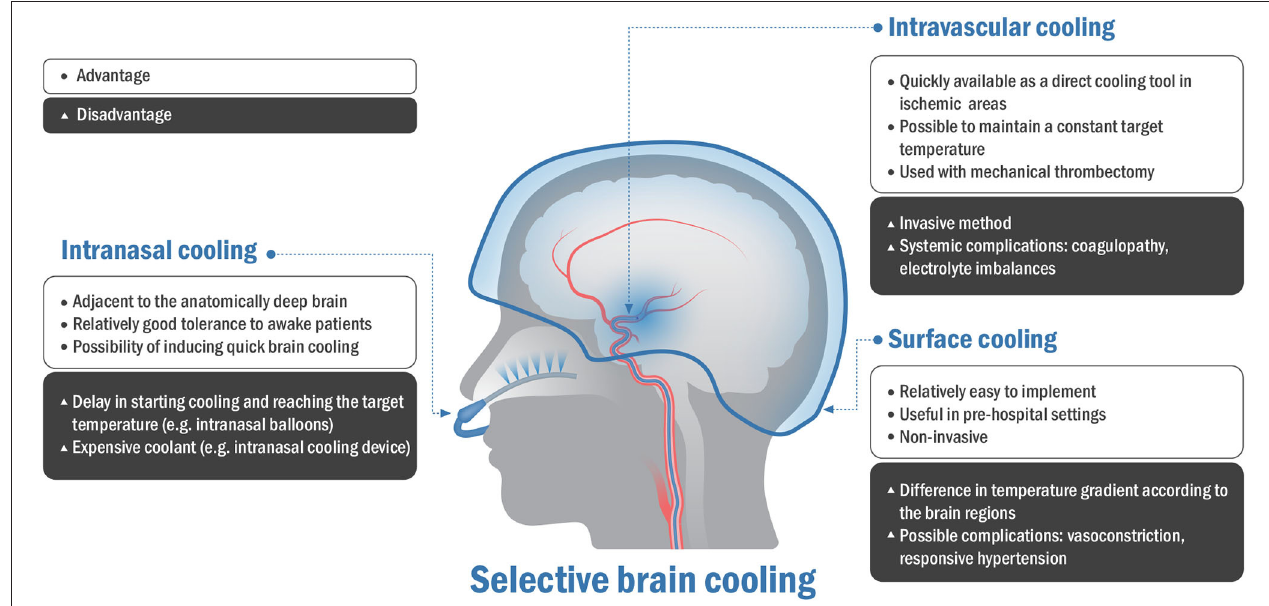
FIGURE 3 | Advantages and disadvantages of three different methods of selective brain